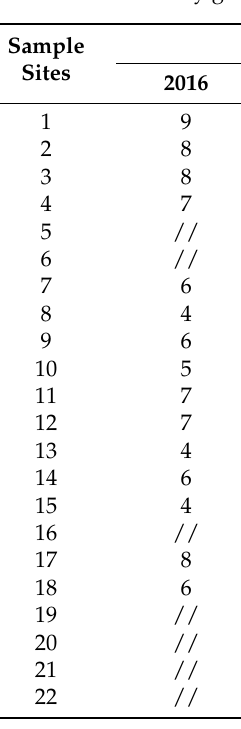
Figure 9. Details of the Case I study area. ( a – c ) are RSPD results of forest, forest–grassland mixture and grassland, respectively; ( d – f ) are the corresponding CV results; ( g – i ) is the corresponding Google Earth image; ( j – l ) are the corresponding in situ pictures. Table 4. Plant diversity grade of sample